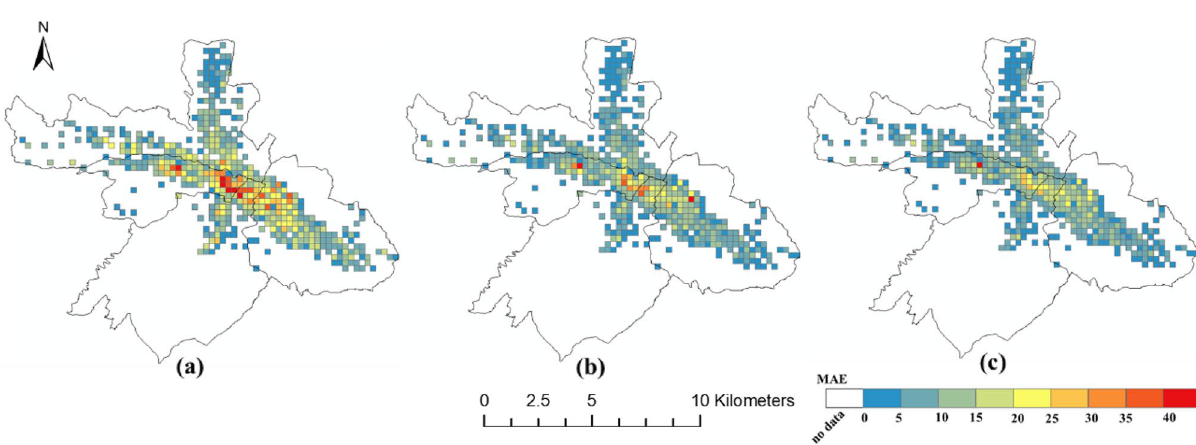
Figure 7. Spatial distributions of the RMSEs of different models: ( a ) SVR; ( b ) TGCN; ( c )